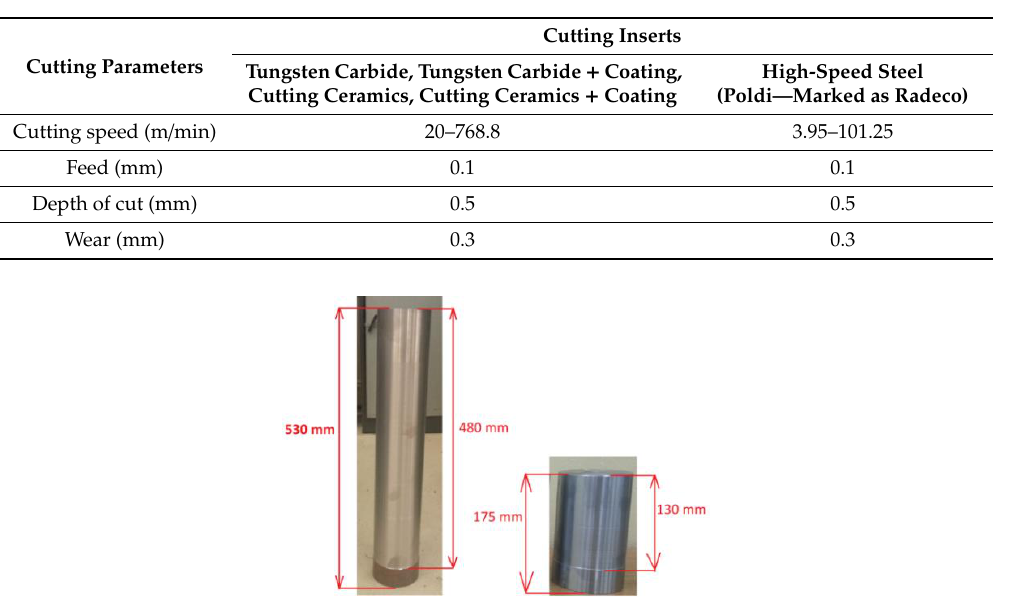
Figure 7. Samples for experiments –conventional lathe sample ( left ), CNC lathe ( right )